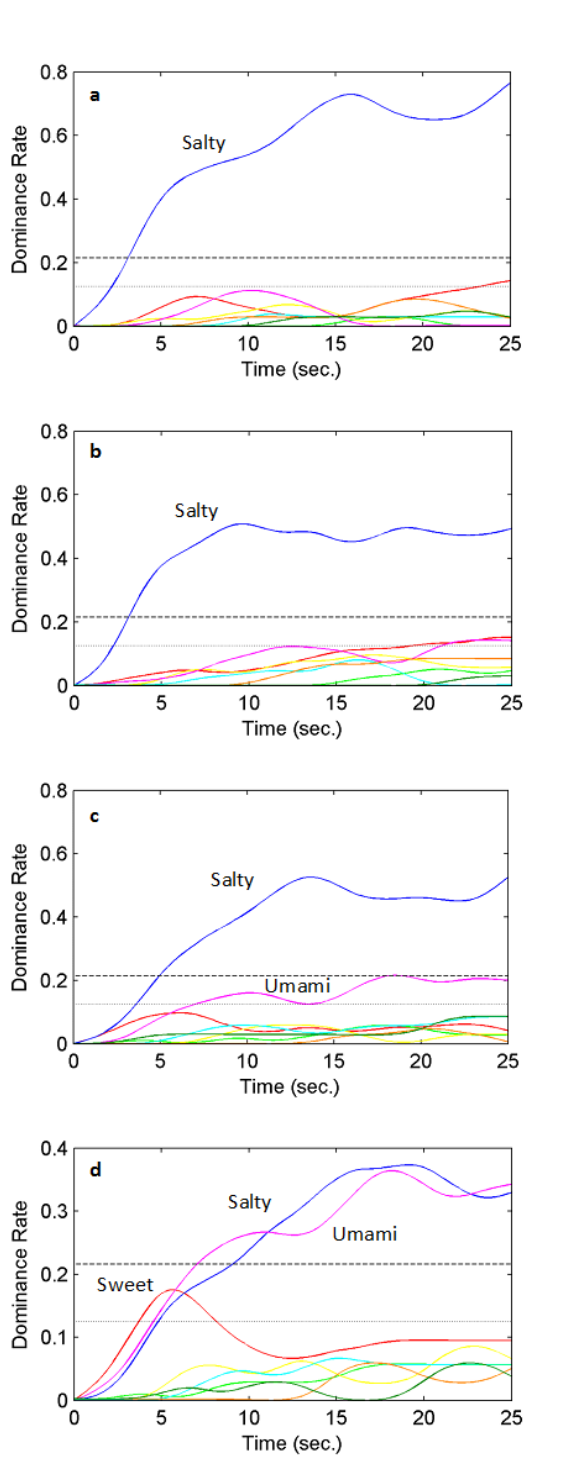
Figure 2 - Graphical representation of the temporal dominance of sensations profile for margarines: a (control - without sodium reduction), b (20.8% less sodium), c (33% less sodium) and d (47.4% less